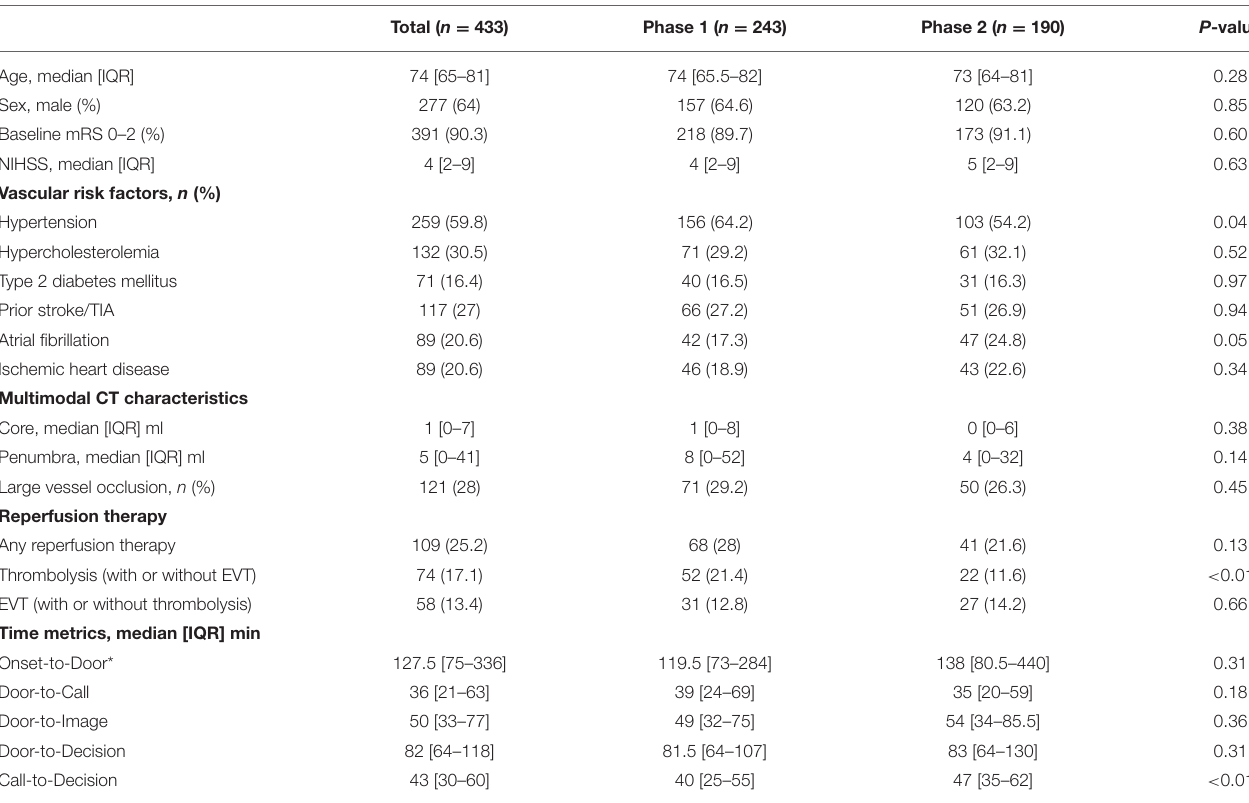
TABLE 1 | Clinico-radiological characteristics and workflow metrics of ischemic stroke and transient ischemic attack patients assessed with mCT. Total ( n = 433) Phase 1 ( n = 243) Phase 2 ( n = 190) P